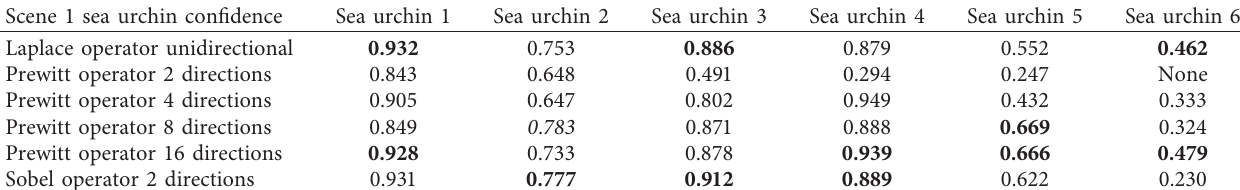
Table 3: Sea urchin confidence in the ISSD algorithm for multidirectional detection in Figure 9(a).